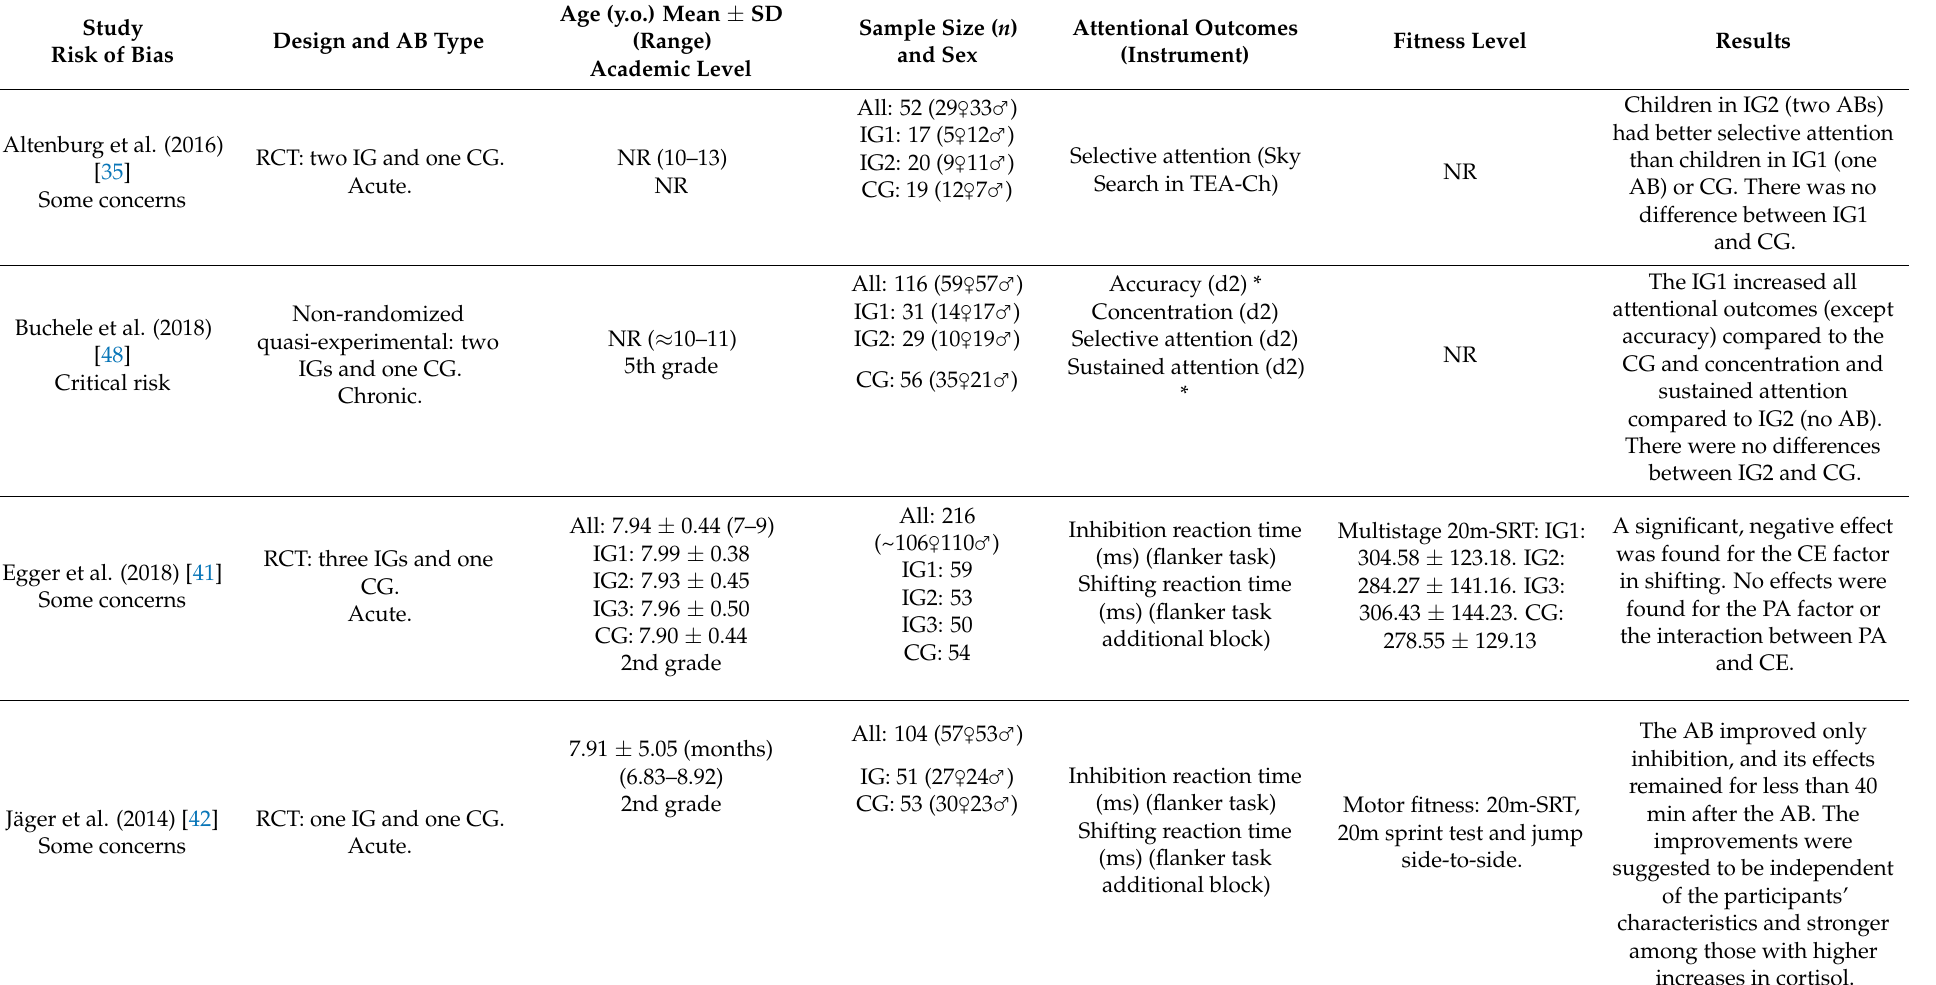
Table 2. Characteristics of the selected studies with a parallel-groups